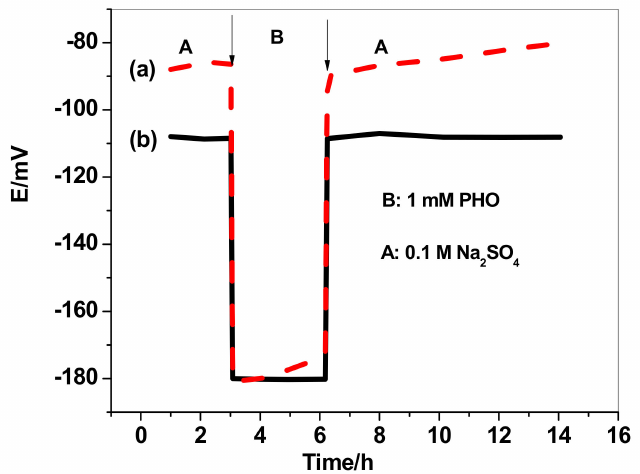
Figure 7. Water-layer tests for both ( a ) SPE/MIP-ISE (dotted line) and ( b ) SPE/MWCNT/MIP-ISE (solid line).